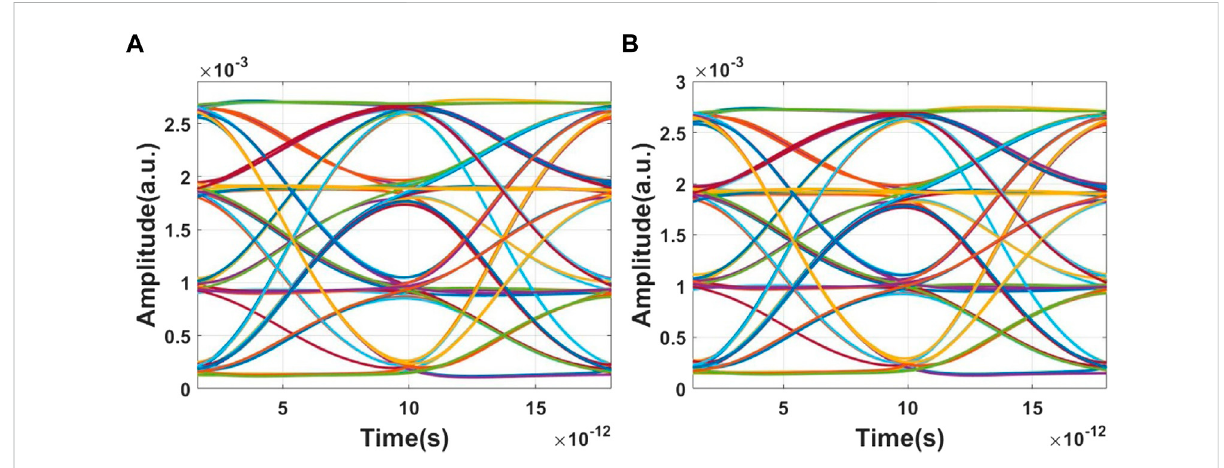
FIGURE 10 SimulatedPAM4eyediagramresults. (A) 120GbaudPAM4signalofbalanced-armMZImodulator (B) 120GbaudPAM4signalofunbalanced-arm MZI modulator.